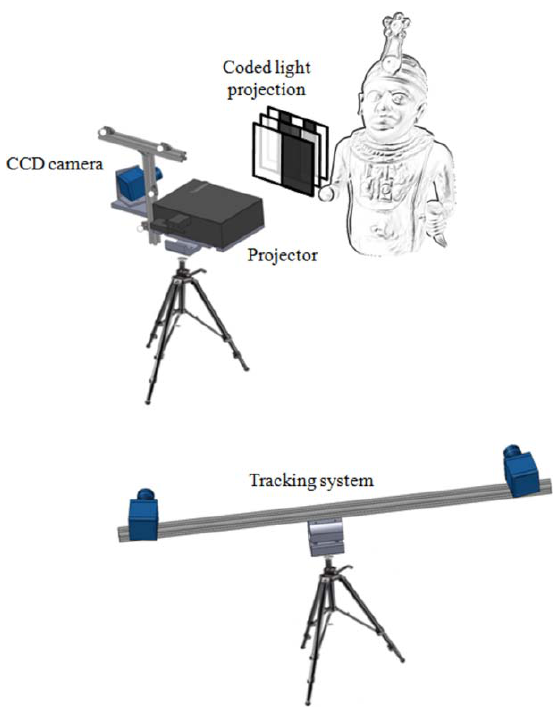
Figure 2. Scheme of the measurement process for a 3D artwork